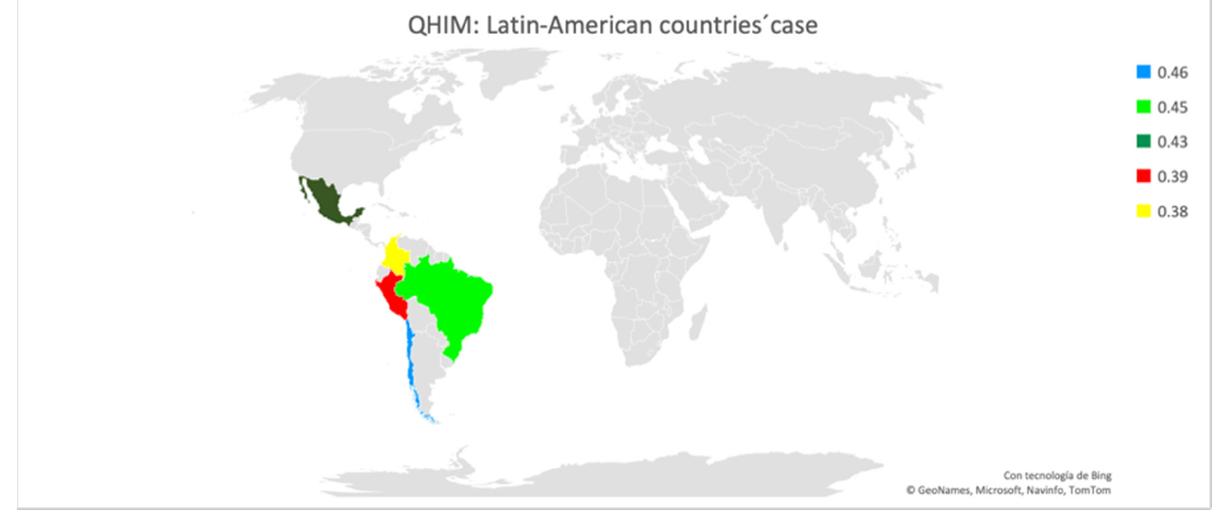
Figure 8. QHIM: Latin-American countries´ case. Source: Own elaboration based on [8,45–53]. It should be remembered that the rating scale used was 11 values [0, 1]. Thus, the